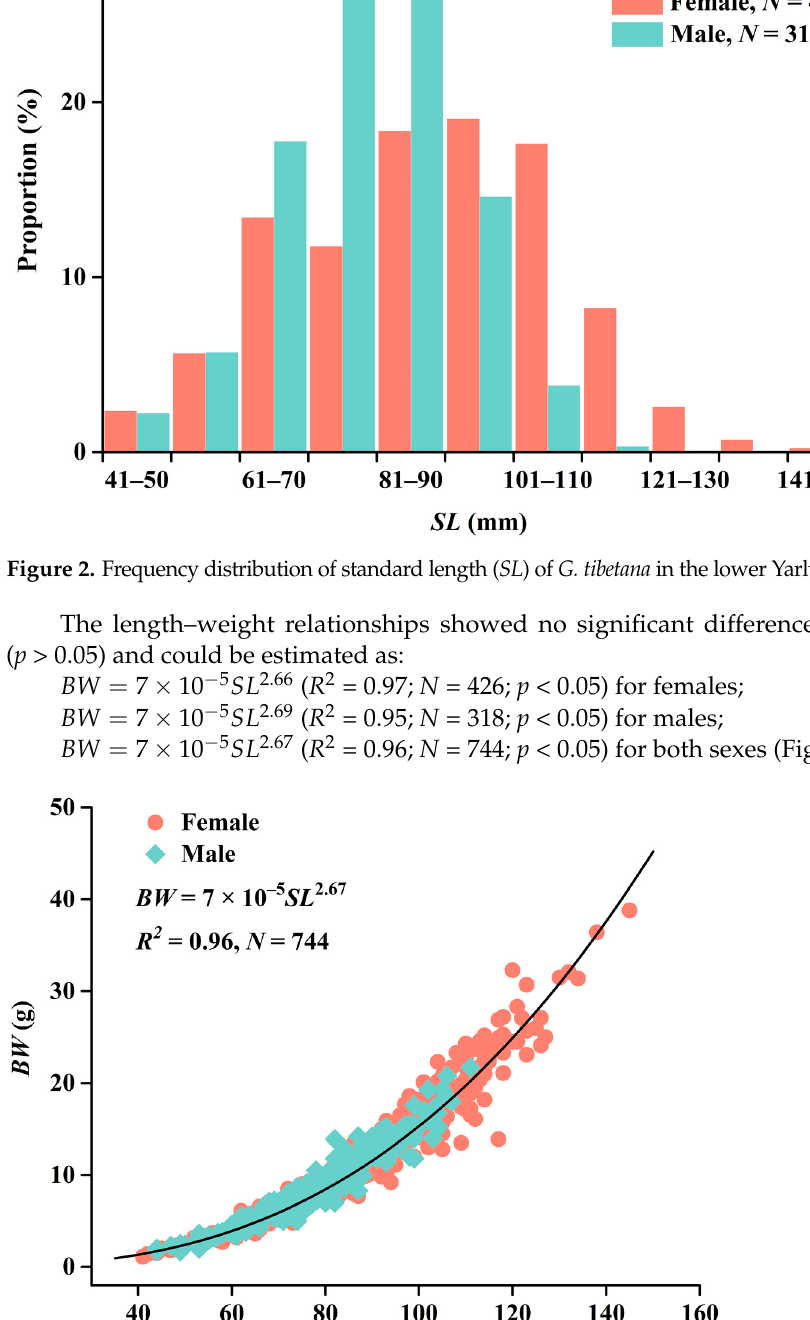
Figure 4. Logistic functions fitting to the proportion of mature individuals by 10 mm standard- length ( SL ) interval for both sexes of G. tibetana in the lower Yarlung Tsangpo River, dotted lines showing the estimated values of standard length at first maturity ( SL 50% ).